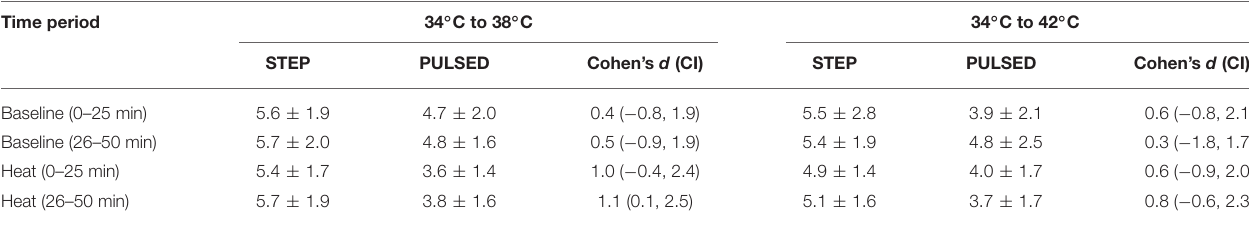
TABLE 2 | CGRP dialysate concentrations from intradermal microdialysis samples. Time